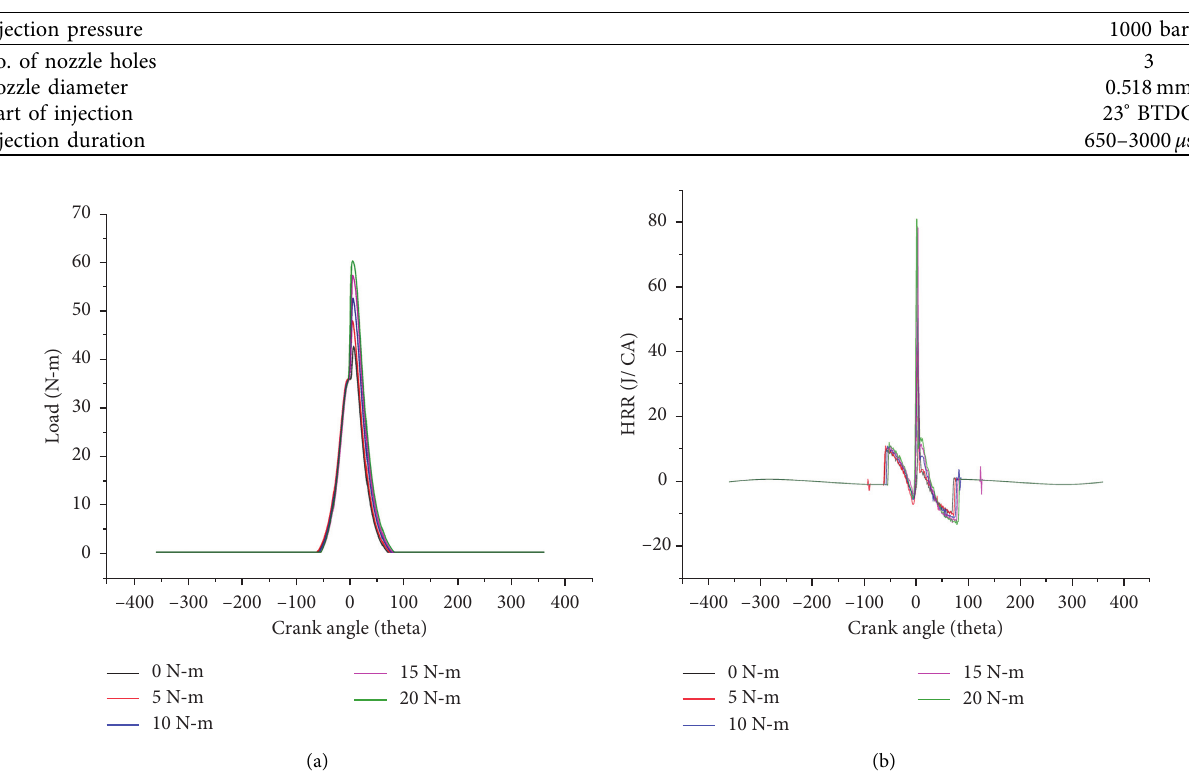
Table 2: Electronic fuel injector specifications.